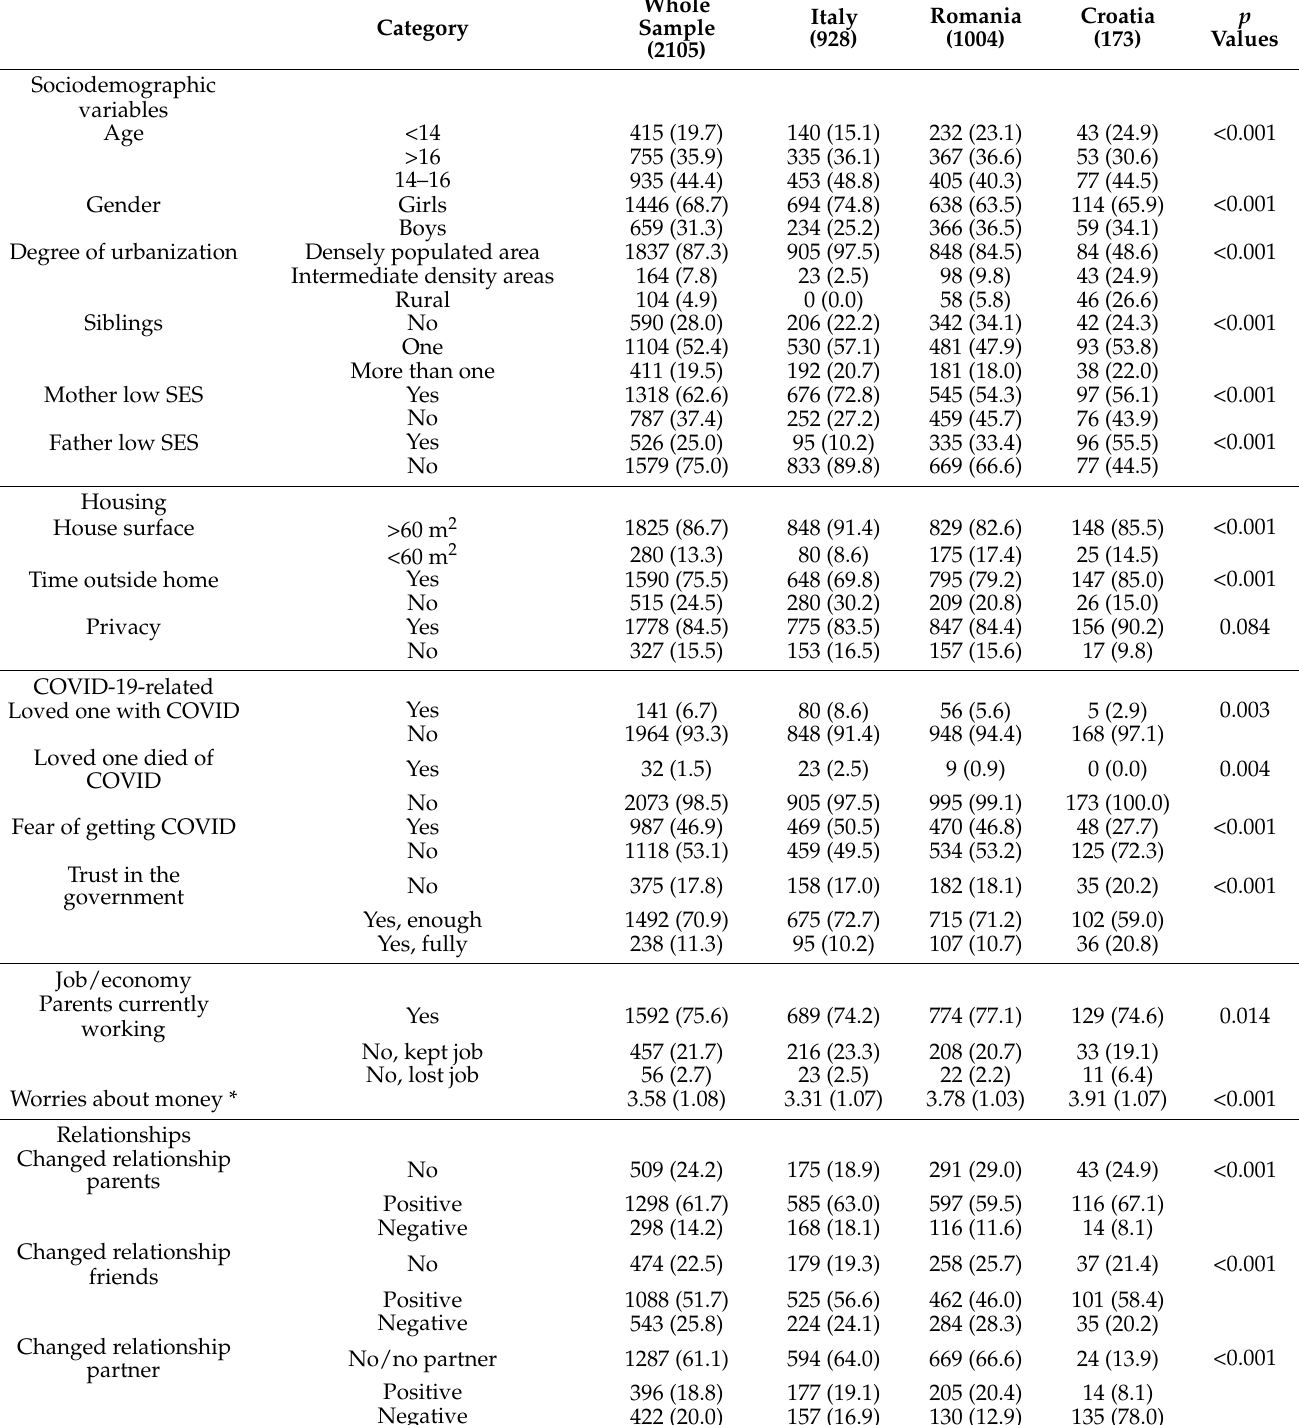
Table 1. Characteristics of the